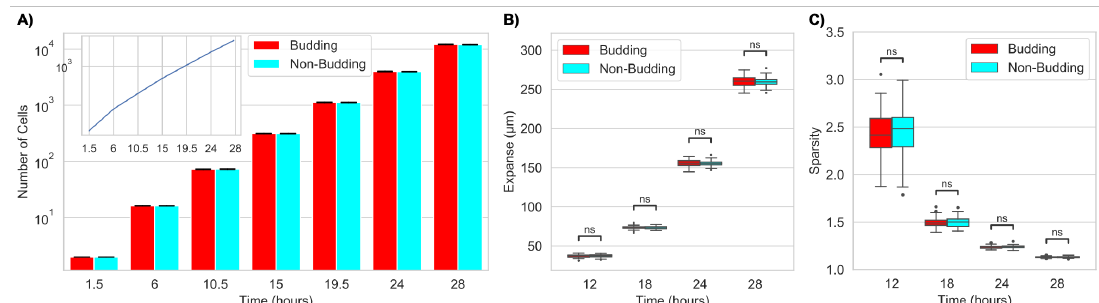
Figure 7. Population Growth, Expanse and Sparsity of Simulated Yeast Colonies in Nutrient-Limited Conditions. ( A ) Colony growth is exponential with doubling time ∼ 123 min (inset). Bar plots represent average number of cells in each colony across all 50 simulations for both budding and non-budding colonies under nutrient-limited conditions calculated at 4.5 h intervals; ( B ) Colony expanse increases over time for both budding and non-budding colonies; ( C ) Colony sparsity decreases to 1 as the size of the colony increases over time for both budding and non-budding colonies. (See Section 2.2.1 for